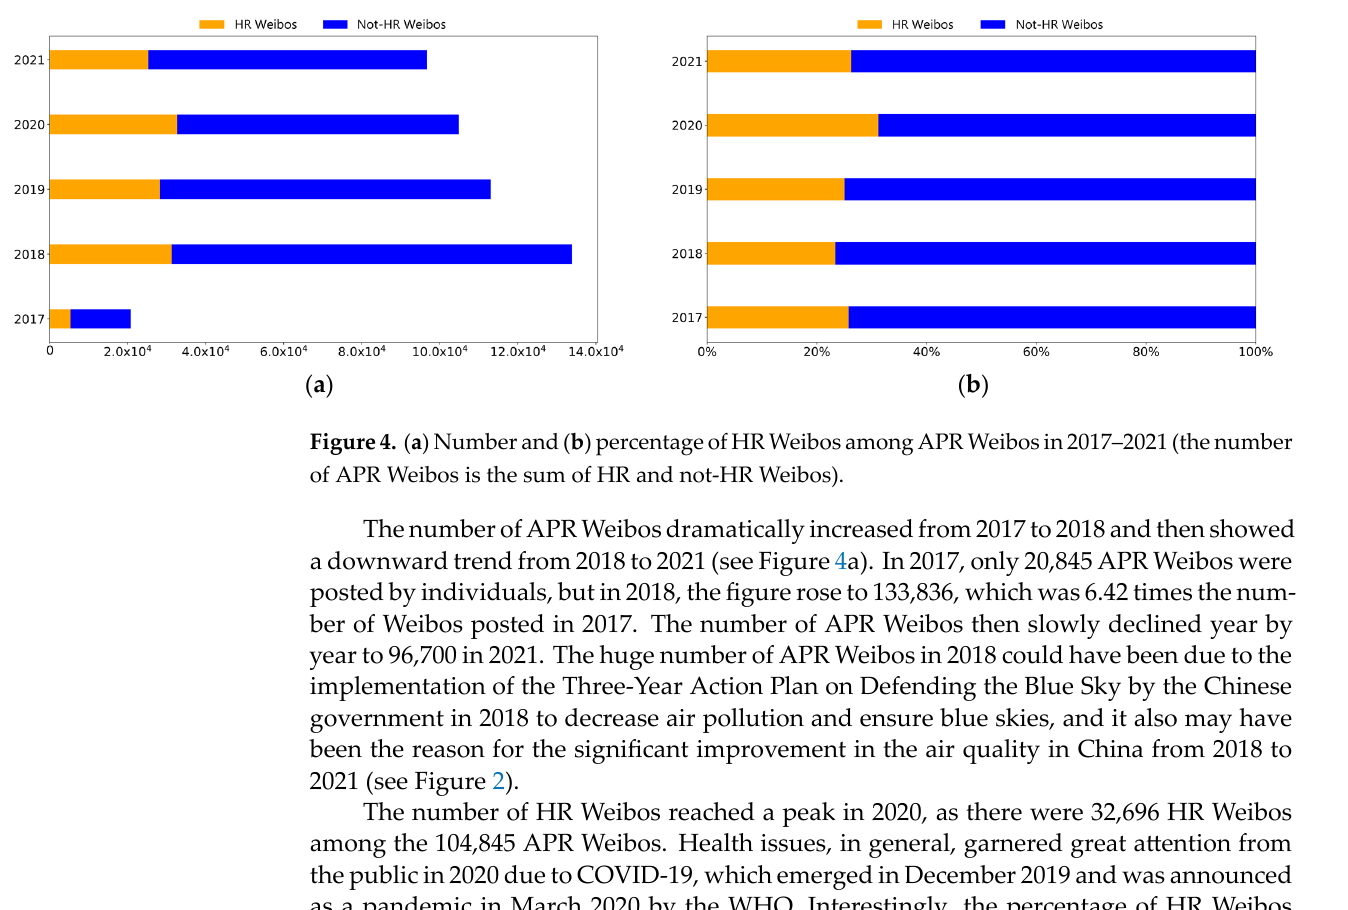
Table 2. Correlation coefficient between APR and HR Weibos in each PAR during 2017–2021.